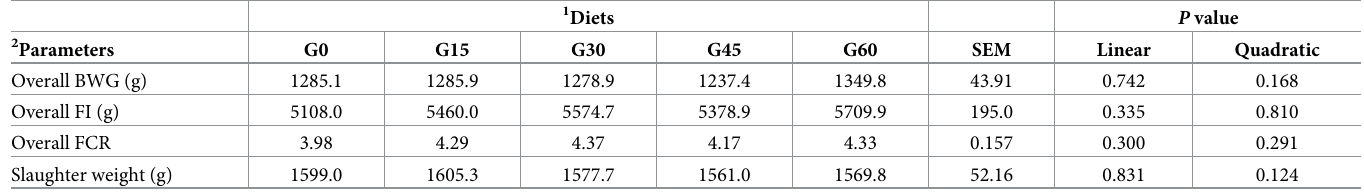
1 Diets: G0 = a standard chicken grower diet without red grape pomace; G15 = a standard chicken grower diet mixed with 15 g/kg red grape pomace; G30 = a standard chicken grower diet mixed with 30 g/kg red grape pomace; G45 = a standard chicken grower diet mixed with 45 g/kg red grape pomace; G60 = a standard chicken grower diet mixed with 60 g/kg red grape pomace.